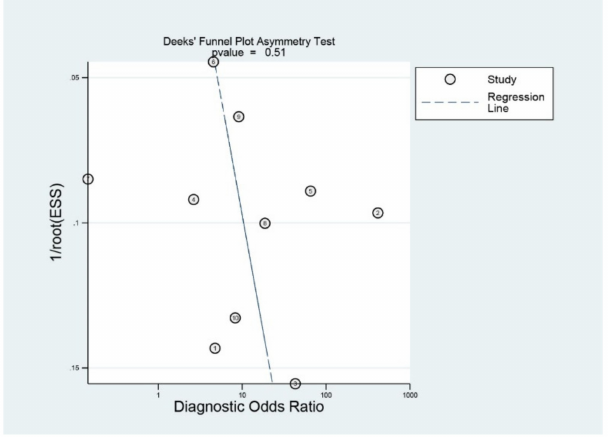
Figure 6. Deek’s funnel